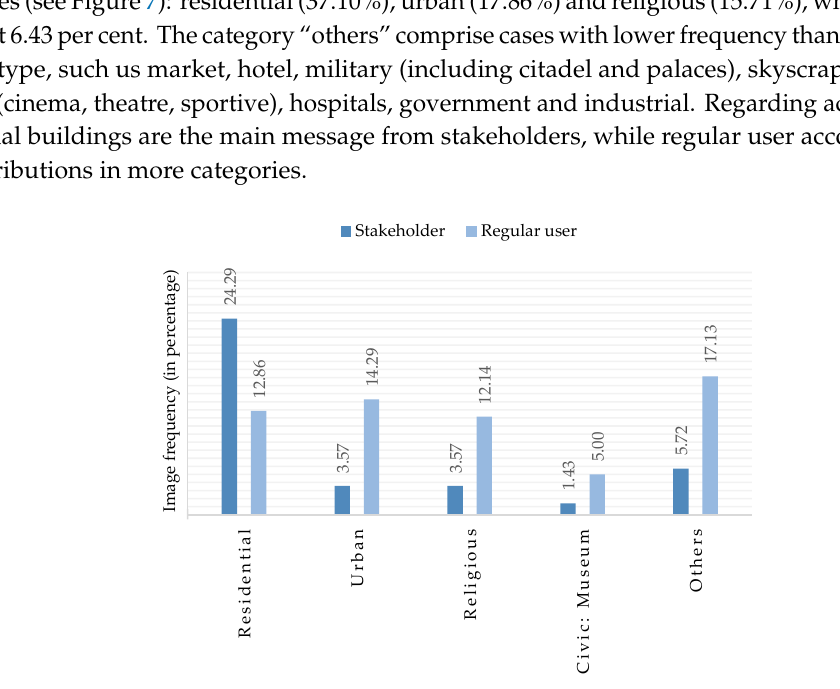
Figure 7. Bar graph on building-type frequency by Instagram user account.